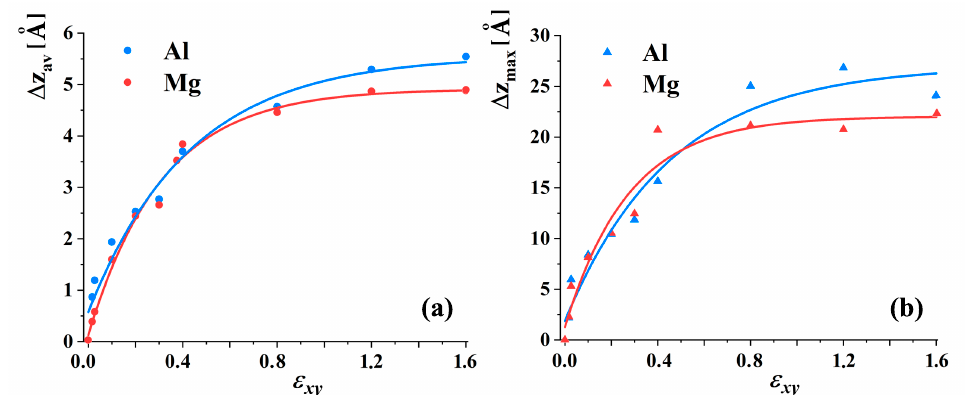
Figure 4. Changes of the atomic positions ∆ z as the function of compression strain. ( a ) ∆ z av , ( b ) ∆ z max